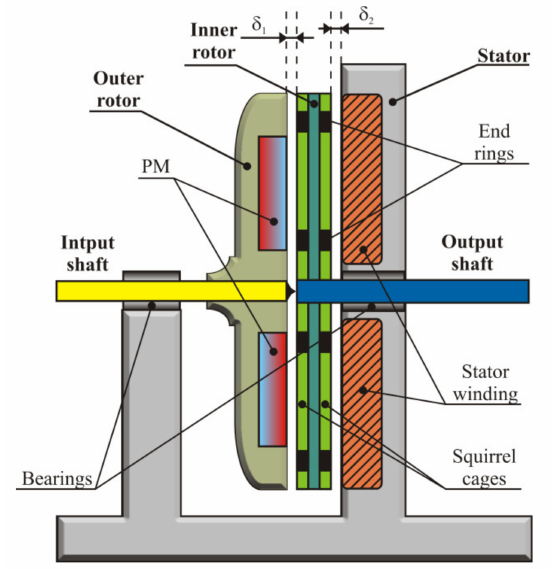
Figure 2. The internal structure of the AFRC unit. Reprinted from ref.